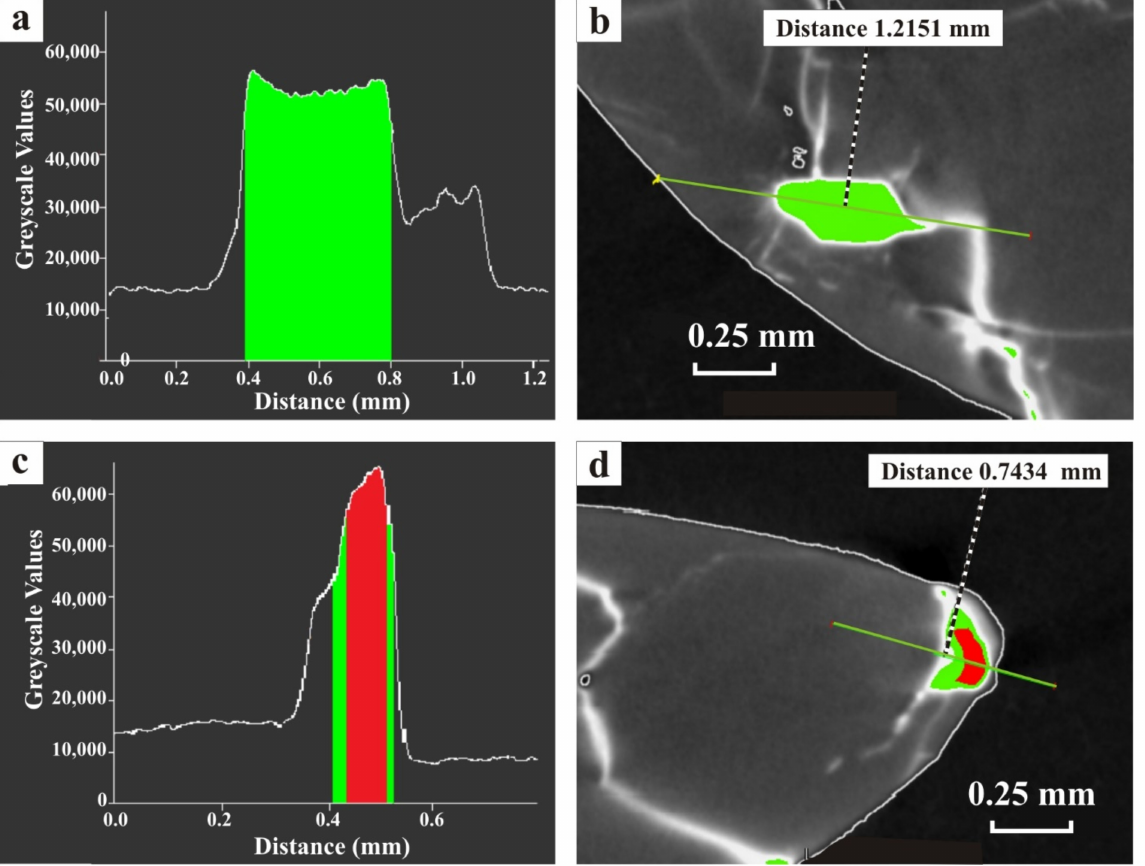
Figure 4. Line distance profile of filled cavity 1 ( a ) and filled cavity 2 ( c ) with their respective CT scan images of the cavities ( b , d ) in the m glass-filled ruby. Different densities are indicated on the greyscale histograms. Cavity 1 displays only one denser filling material (green) while cavity 2 displays two different greyscale density filling materials (red and green) due to the under-estimation of the threshold position.